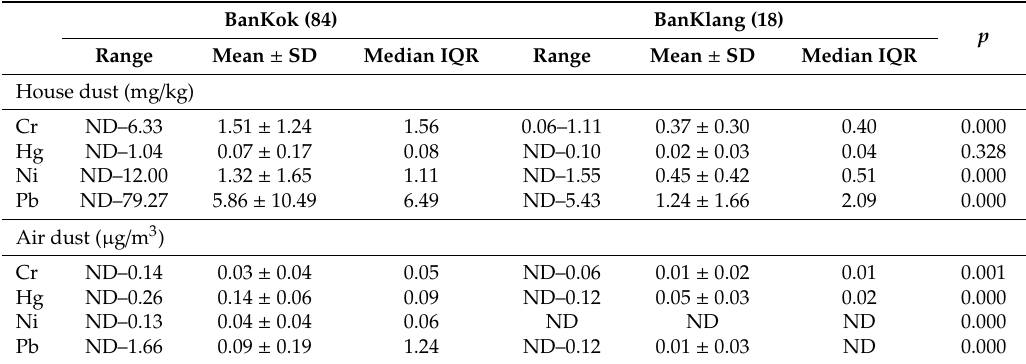
Table 3. Average concentrations of chromium (Cr), mercury (Hg), nickel (Ni), and lead (Pb) in house dust and airborne dust stratified by village.